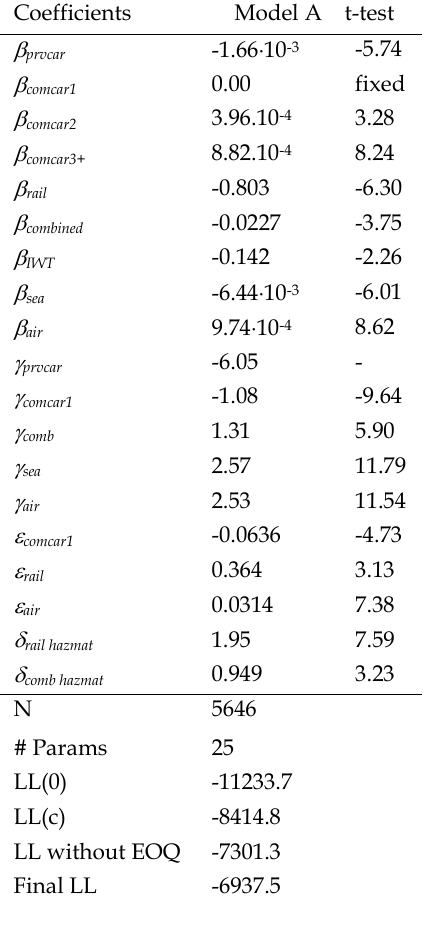
Table 3. Estimation of the mode choice